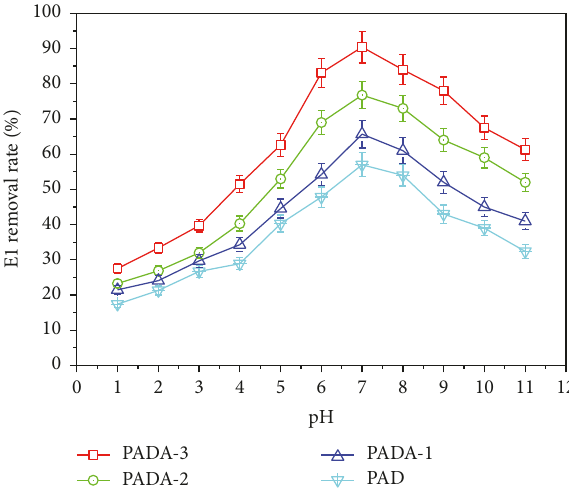
Figure 8: The E1 removal rate after flocculation at various